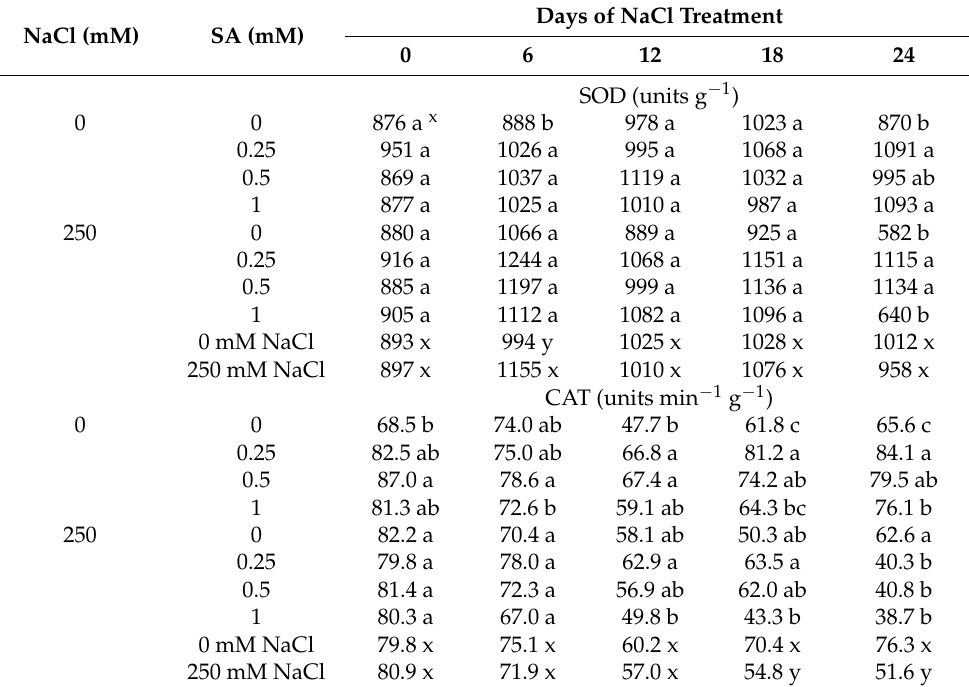
Table 4. Effect of salicylic acid on SOD and CAT activity of perennial ryegrass under two salt conditions.